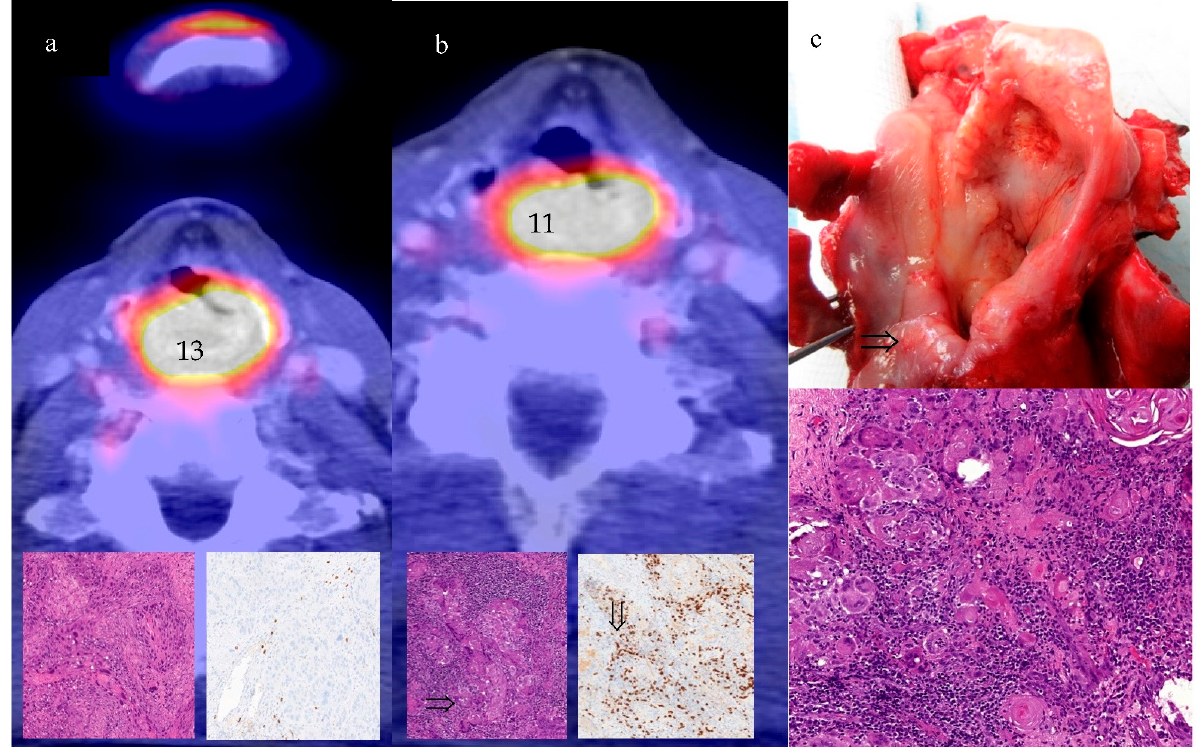
Figure 3. ( a – c ): supraglottic laryngeal cancer before induction ( a ) with SUV max pre: 13, HE staining: squamous cell cancer and sparse CD8+; ( b ) after induction chemotherapy plus durvalumab or Tremelimumab, SUV max post: 11, regressive changes but ( ⇒ ) still tumor cells and infiltration of CD8+ lymphocytes ( ⇓ ); ( c ) the larynx after laryngectomy with suspicion of persisting tumor ( ⇒ ) HE staining without any tumor cells but lymphocytes.